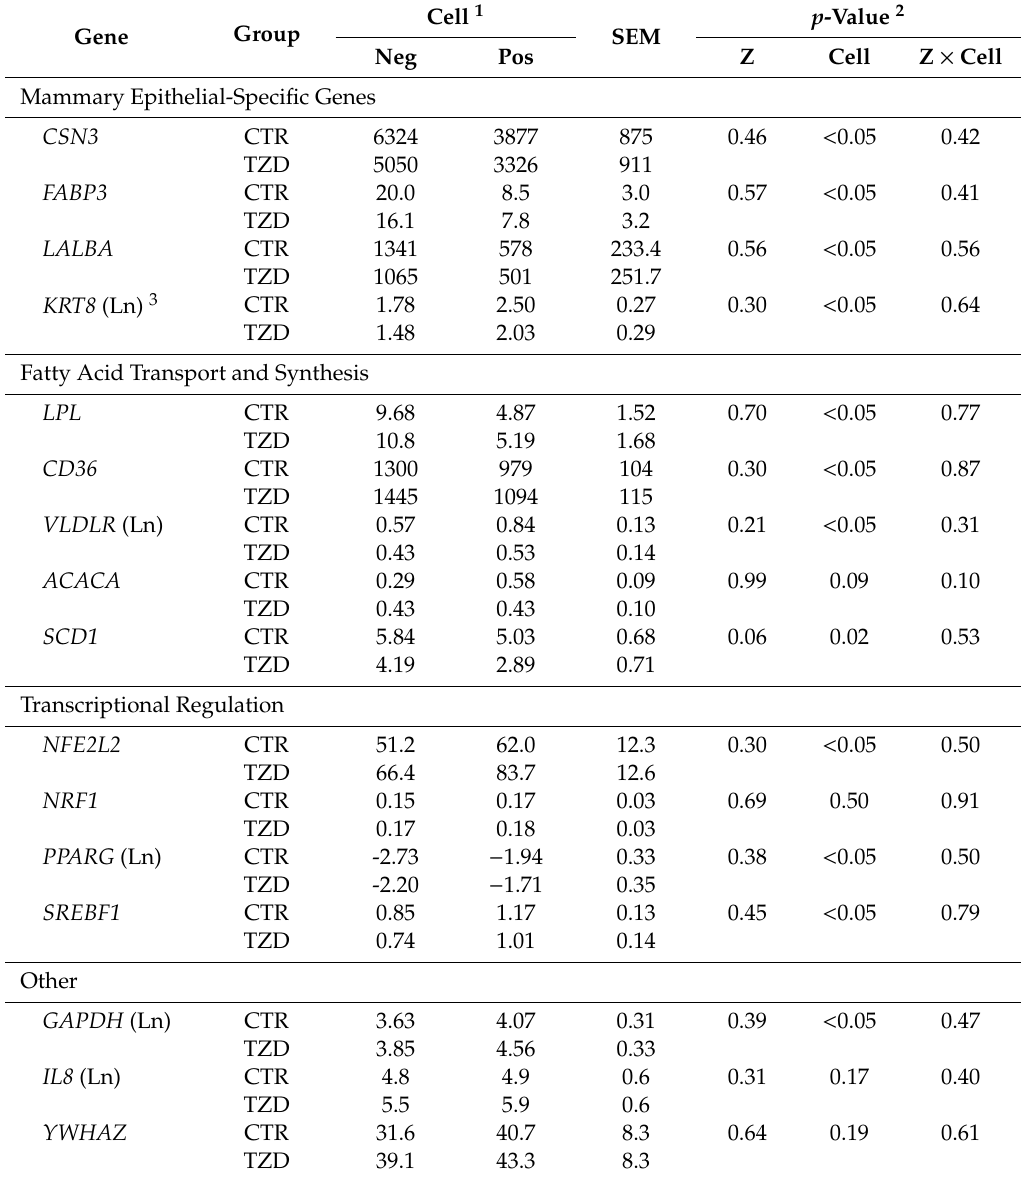
Table 4. Transcript abundance of selected genes normalized by the geometric mean of RPS9 , UXT , and MRPL39 in mammary epithelial cells (MEC) in goats receiving 2,4-thiazolidinedione (TZD) or saline